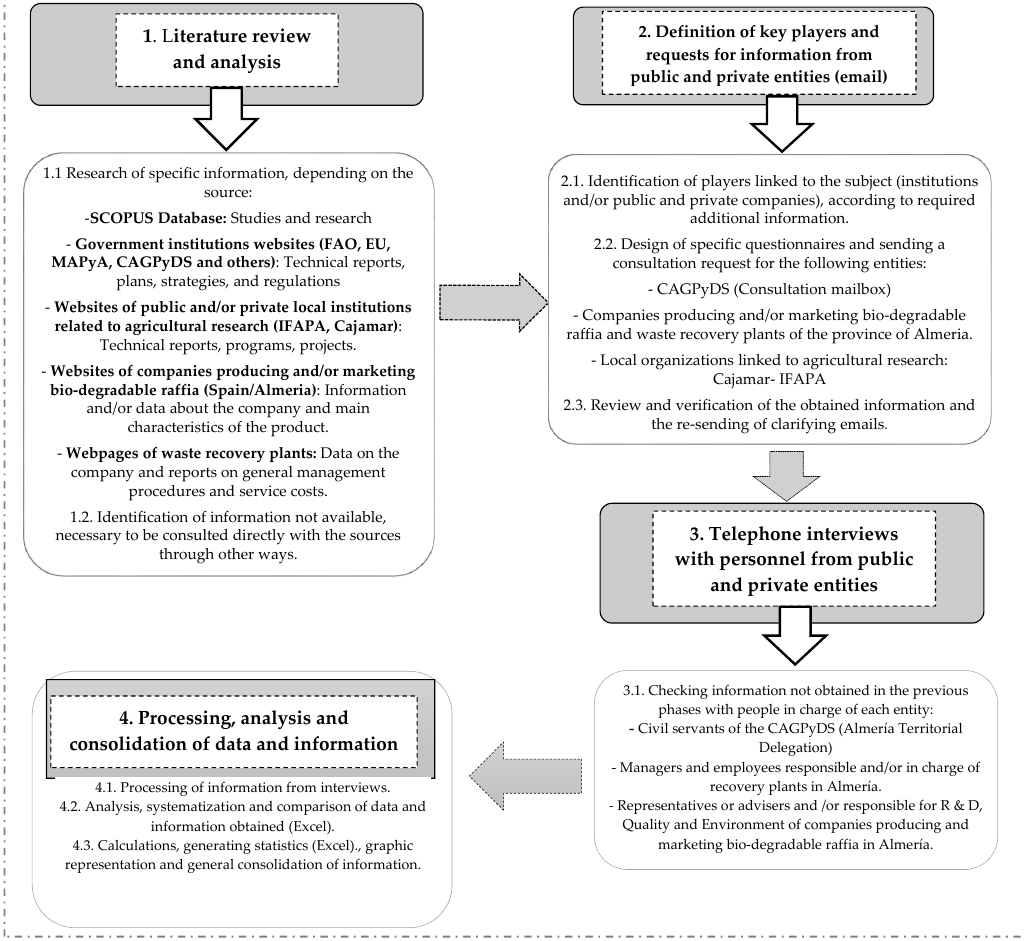
Figure 2. Main stages of the study elaboration process. FAO: Food and Agriculture Organization of the United Nations. EU: European Union. MAPyA: Ministry of Agriculture, Fisheries and Food. CAGPyDS: Department of Agriculture, Livestock, Fisheries and Sustainable Development of the Regional Government of Andalusia (Junta de Andalucía). IFAPA: Andalusian Institute for Research and Training in Agriculture, Fisheries, Food and Organic Production.